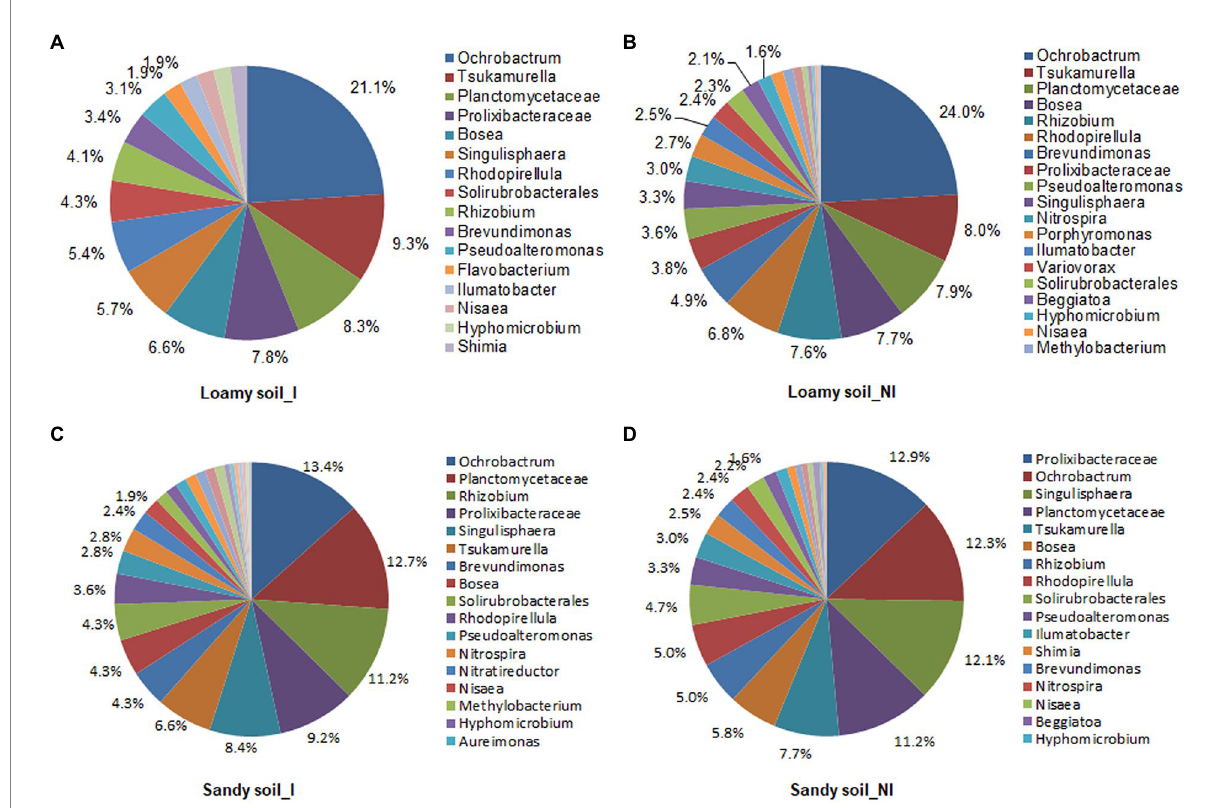
FIGURE 6 Schematic representation of bacterial communities in loamy and sandy soil with and without inoculation of Enterobacter cloacae NG-33 strain. The differences of bacterial communities composition among the inoculated (A,C) and non-inoculated (B,D) in loamy and sandy soil with the supplemental application of TCP. I, inoculation; NI,